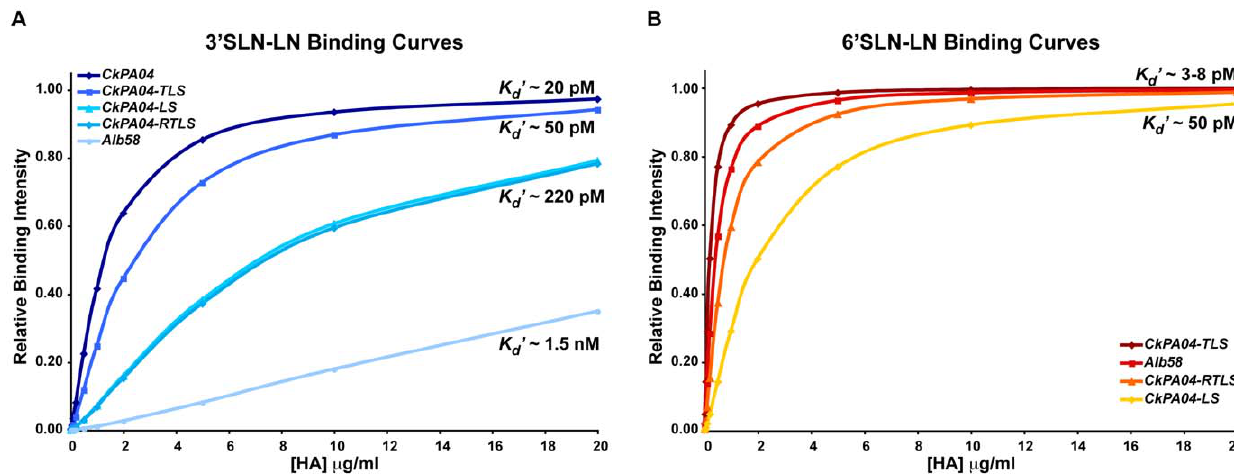
Figure 6. Glycan receptor-binding affinities of the mutant forms of CkPA04 HA. A , shows the theoretical binding curves (with the apparent binding constant K d ’ ) that depict the differences in the binding affinity of the WT and mutant H2N2 HAs to the representative avian receptor (3 9 SLN-LN). B , shows the theoretical binding curves that depict the differences in the binding affinity of the WT and mutant H2N2 HAs to the representative human receptor (6 9 SLN-LN). The range of K d ’ values (3–8 pM) is shown for CkPA04-TLS , Alb58 and CkPA04-RTLS that is contrasted with the K d ’ value of CkPA04-LS . The binding curves were generated by fitting to the Hill equation (see Methods) and plotting the theoretically calculated fractional saturation ( y-axis ) against HA concentration ( x-axis ). The n value for all the binding events is around 1.3.